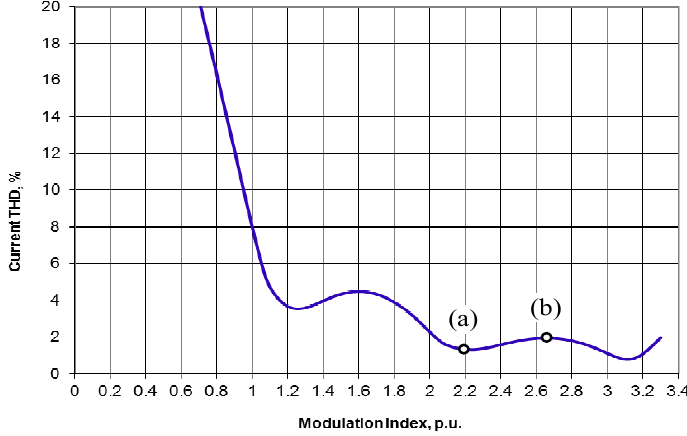
Figure 11. Minimal current THD vs. modulation index for n = 3.